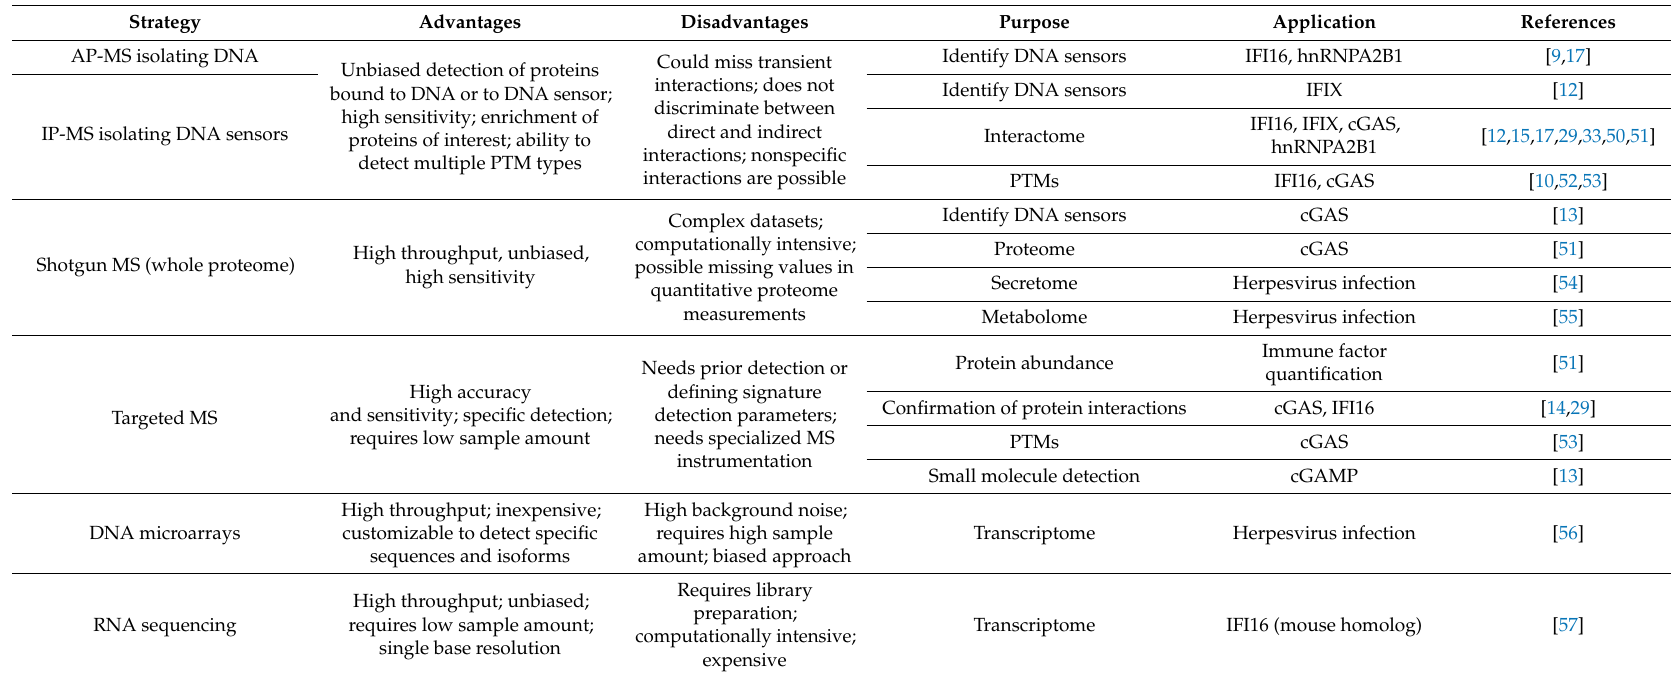
Table 1. Omics techniques used for the discovery and characterization of nuclear DNA sensors and related host antiviral